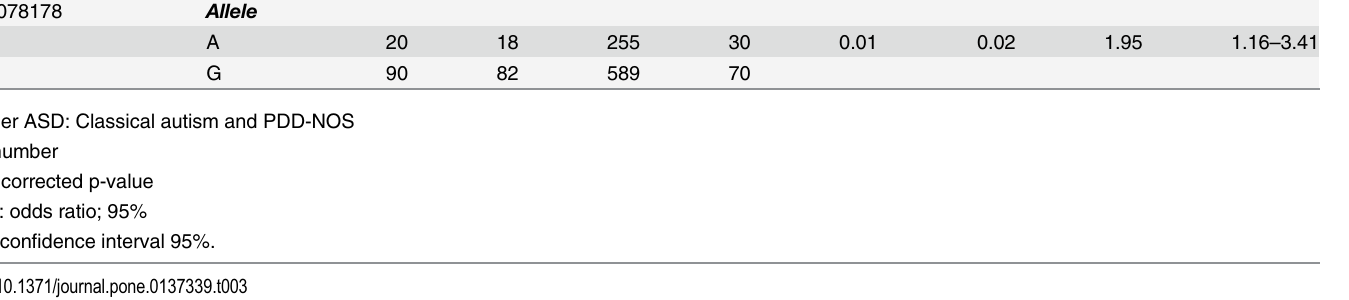
values exhibit increasing trend along the CLEC7A genotype groups: rs 2078178 AA, AG and